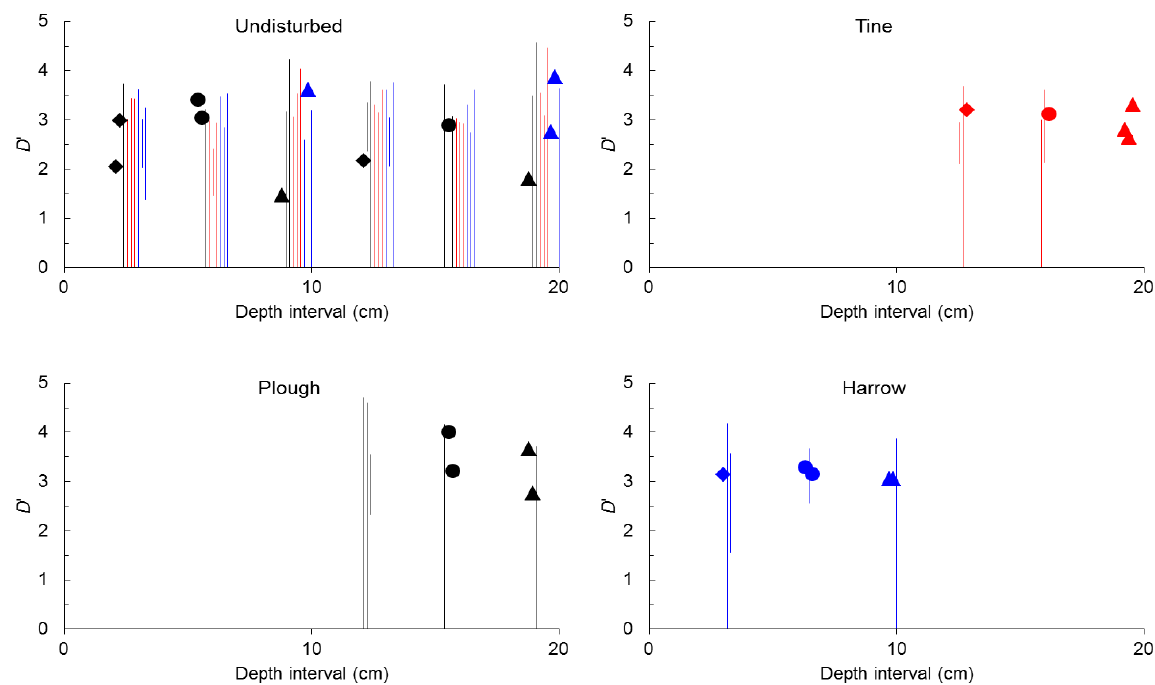
Figure 1. Value (points) or range (bars) of size-number distributions of seeds expressed by D ’ for 0–10 cm or 0–20 cm soil depth before tillage (undisturbed) and after tine, harrow or